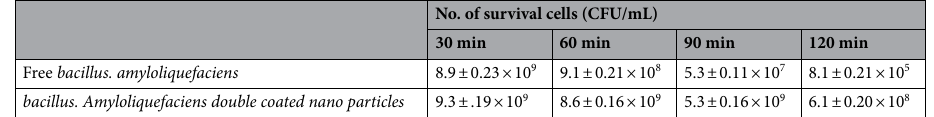
Table 1. Cell survivability (log CFU/mL) of free and double coated nano particles bacillus. Amyloliquefaciens (BANPs) after treatment in activated gastric juice then activated intestinal juice with bile salt. SE standard error. a,b,c Means of the bars with different letters were significantly different among groups (P <